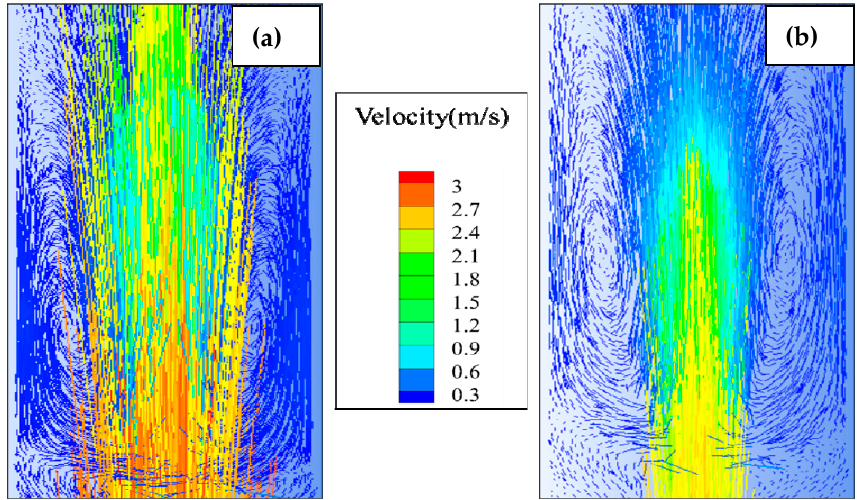
Figure 3. Comparisons of velocity vectors (m/s), obtained in the reaction zone of the CJM reactor where ( a ) using surface growth only model for crystallization and ( b ) using combined aggregation and surface growth model, respectively.